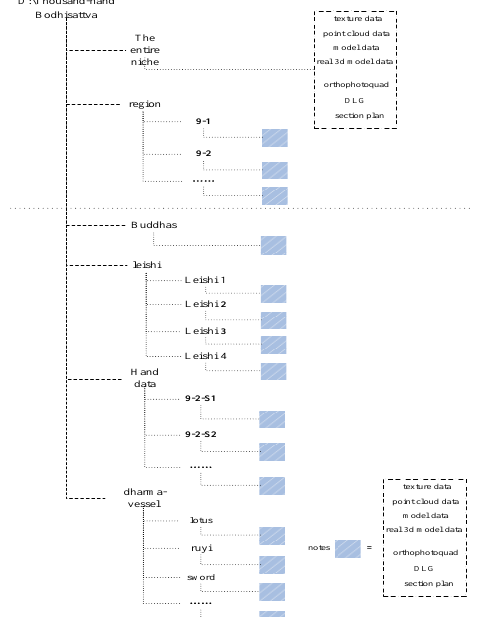
Fig.6. File Management Structure Diagram of The Thousand-hand Bodhisattva